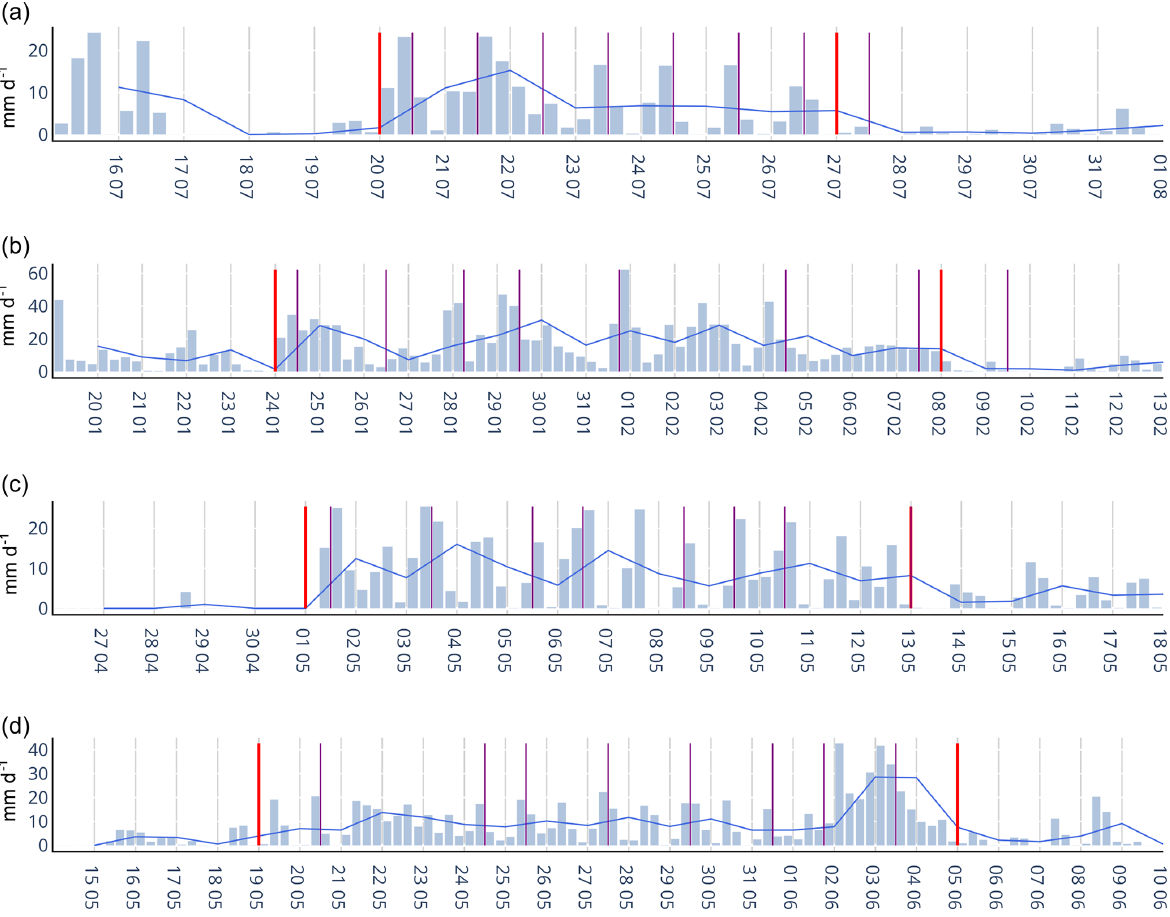
Figure 2. Time evolution of the wet spells illustrated in Figs. 3–6. The panels show the precipitation evolution during the longest wet spell at (a) 57 ◦ N, 37 ◦ E near Moscow, Russia, in 2013, (b) at 66 ◦ N, 14 ◦ E in Norway in 1989, (c) at 43 ◦ N, 12 ◦ E in Tuscany, Italy, in 2018, and (d) at 48 ◦ N, 25 ◦ E in Romania in 1988. Bars depict 6-hourly precipitation (multiplied by 4), while the bold blue line depicts daily precipitation accumulations. Daily precipitation is depicted for each day at 00:00UTC and refers to the precipitation accumulation over the preceding 24h. Red bars mark the onset and termination of each spell, while purple lines indicate the times for which fields are shown in Figs. 3–6. Light vertical lines locate 00:00UTC of each